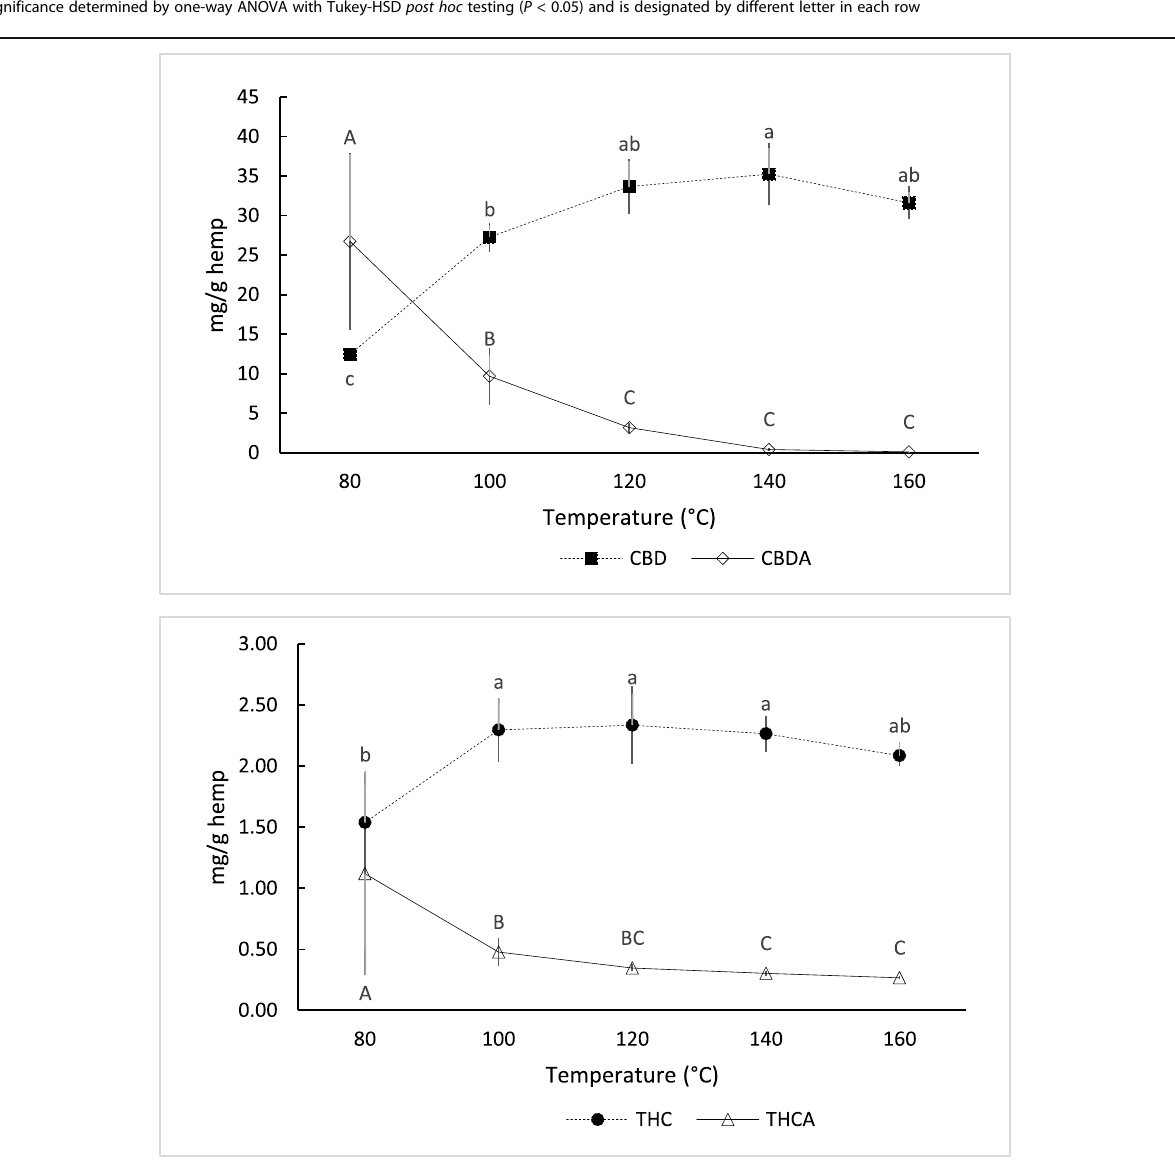
Fig. 1 Comparative concentrations of two common cannabinoids undergoing thermo-chemical conversion. A CBDA to CBD and B THCA to